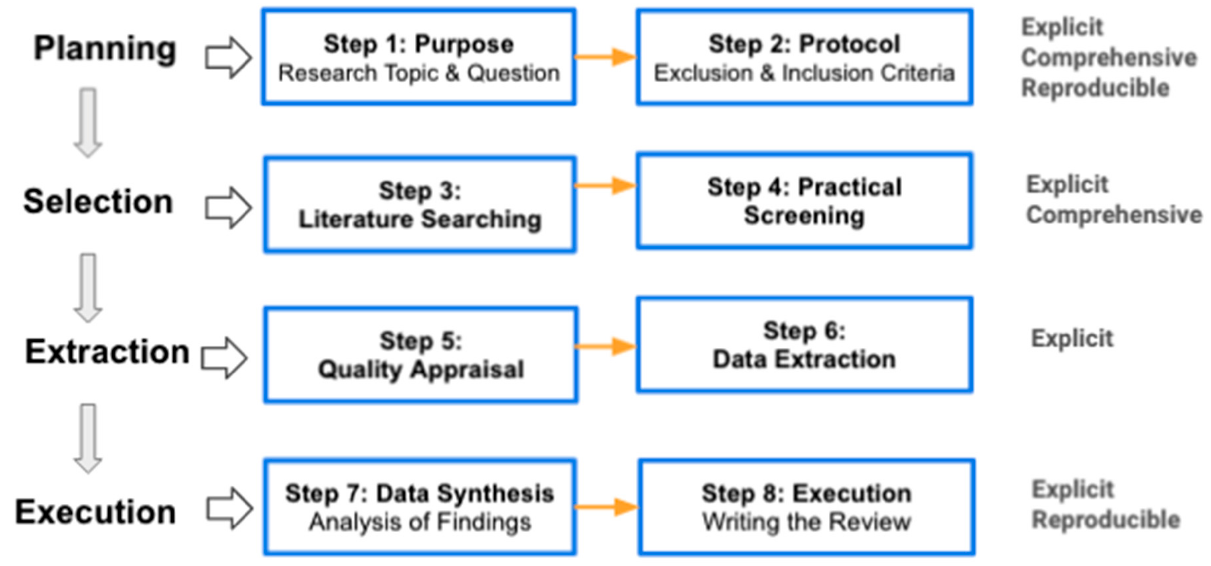
Figure 1. Illustrating Systematic Review Process (Okoli and Schabram, 2010).